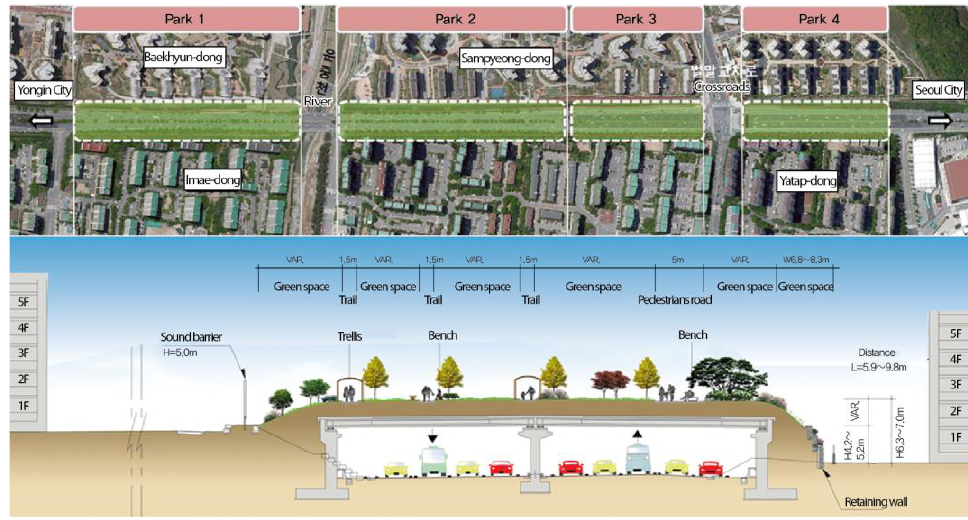
Figure 1. Expressway between Bundang and Suseo (Google Map), upper park area, and cross-section of standards.